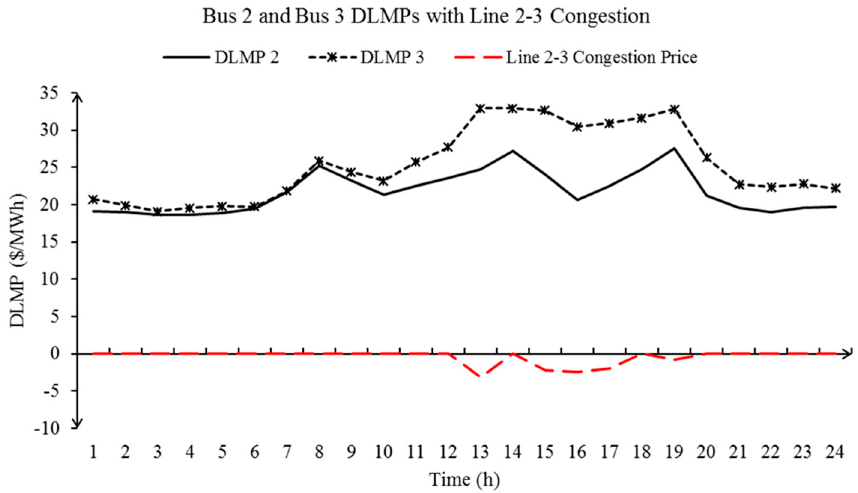
Figure 10. DLMP at Bus 2, 3, and the effect of congestion at Line 2–3.